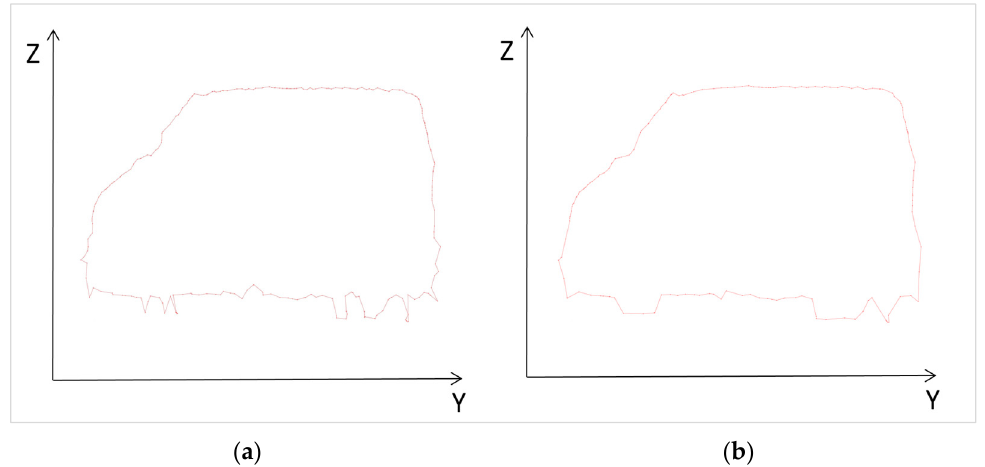
Figure 9. An example of re-sampling the side projection profile of point clouds of a vehicle. Note: before re-sampling ( a ); after re-sampling ( b ).